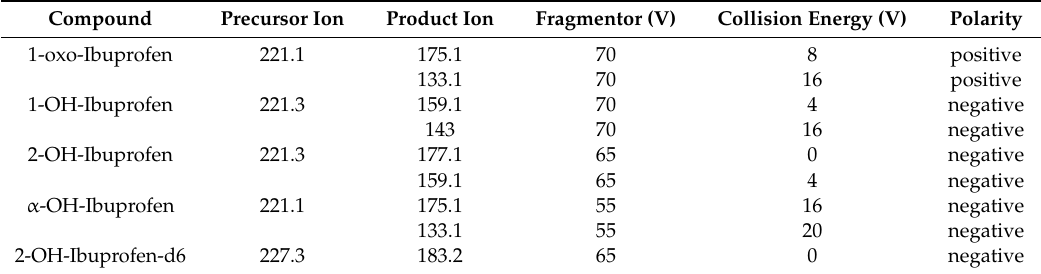
Table 6. Mass spectrometer parameters for the ibuprofen oxidation